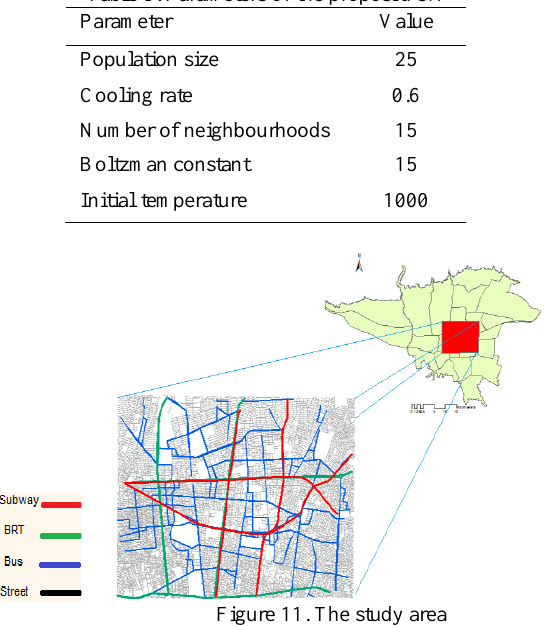
Table 3. Parameters of the proposed SA